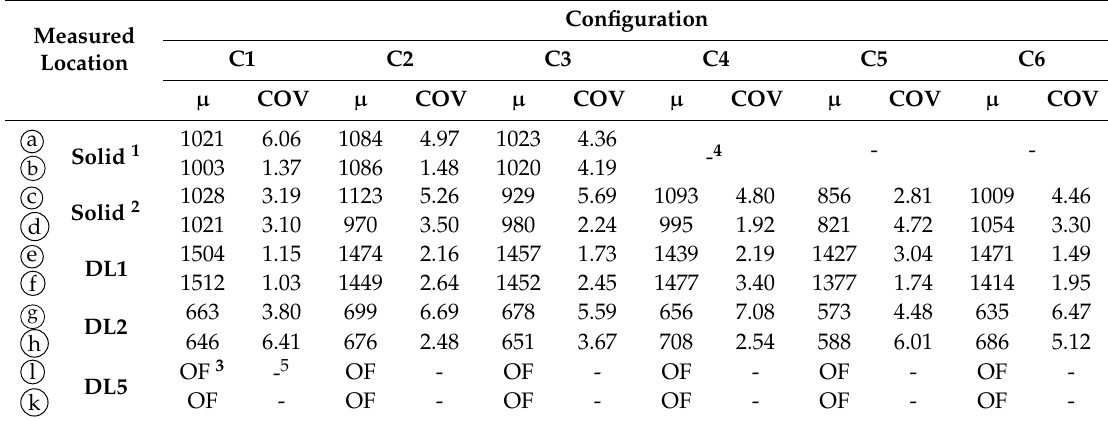
Table 1. Average electrical resistivity of concrete slab specimens 1 and 2 at di ff erent probe configurations and di ff erent measurement points for large delamination defects.